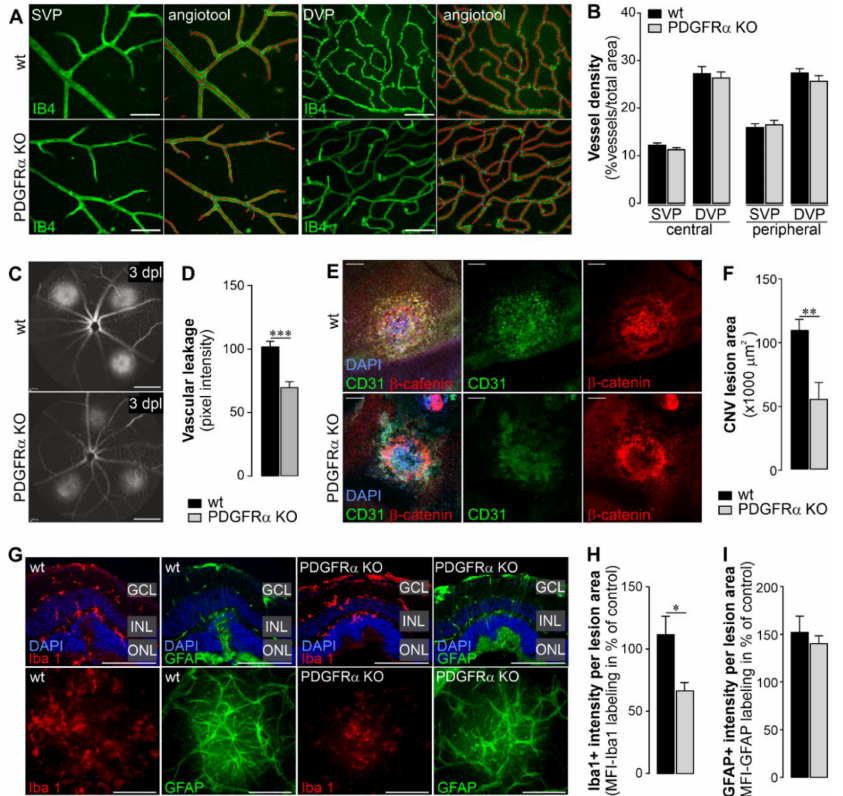
Figure 5. Vascular and inflammatory effects of specific deletion of PDGFR α in Müller cells. ( A ) Retinae from wildtype (wt) and PDGFR α KO mice were dissected, labeled with isolectin B4 (IB4) to label blood vessels, and flatmounted. Panels show representative retinal images from the superficial vascular plexus (SVP) and the deep vascular plexus (DVP) taken in central areas from